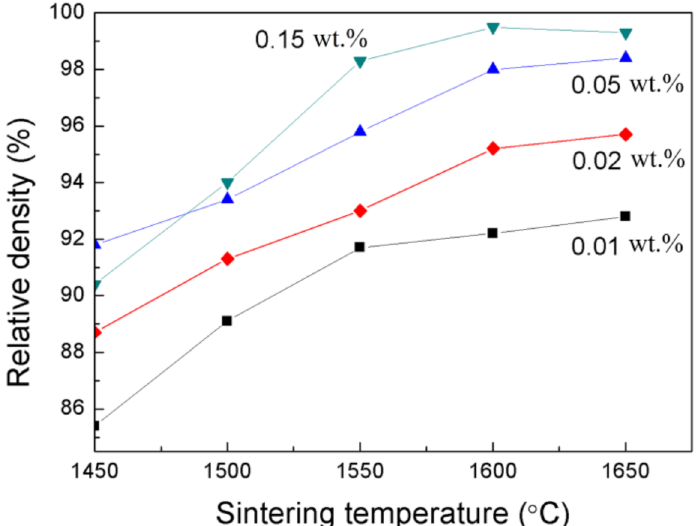
Figure 1. Relative density versus vacuum sintering temperature of the Y 2 O 3 samples with different CaO contents.